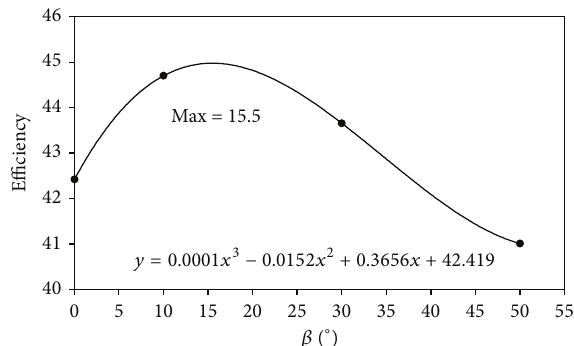
Figure 20: Curve fitting to the data of symmetric angle forward blades at design flow